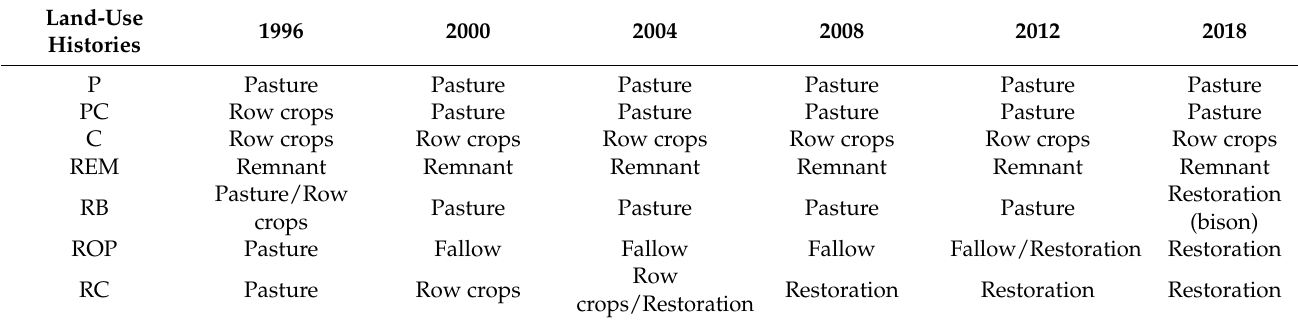
Table 1. History of land use for 7 land-use histories at Midewin National Tallgrass Prairie. Land uses are for the month of January in the listed year. P is cow pasture, PC is pasture converted from row crop fields, C is row crop fields, REM is remnant prairie, RB is restored bison prairie, ROP is restored old pasture, and RC is restored from row crop